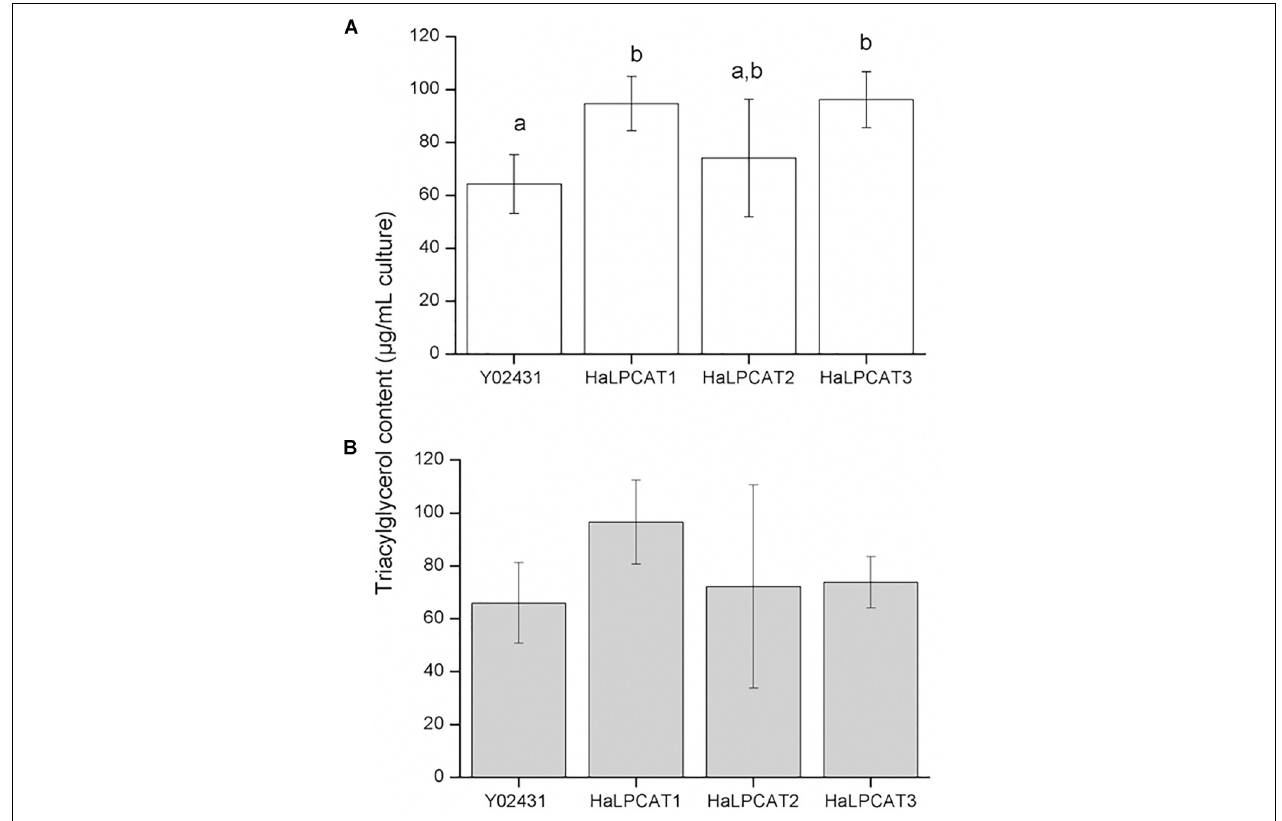
FIGURE 5 | Triacylglycerol content of Saccharomyces cerevisiae strain Y02431 (ALE1) expressing sunflower LPCATs in the absence (A) or presence of Camelina sativa fatty acid desaturase 2 expression (B) . Data represent the average of four independent preparations, ± standard deviation. The letters indicated the groups of statistical significance according to a one-way ANOVA with Tukey post hoc analysis at a significance level of